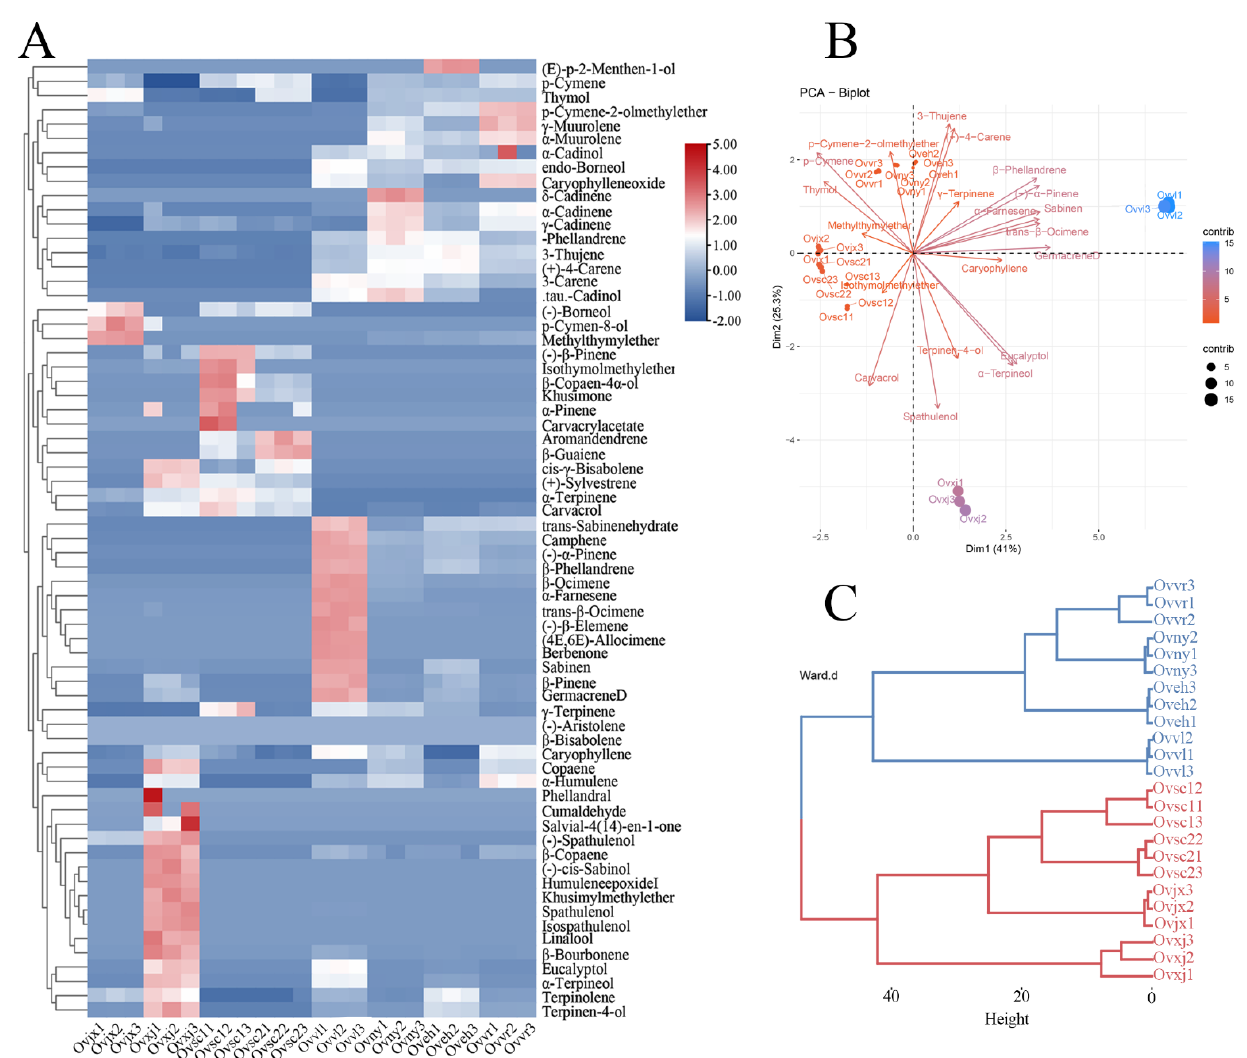
Figure 1. Composition analysis of OEOs. The results are illustrated by a heatmap ( A ), PCA plot ( B ), and dendrogram ( C ).